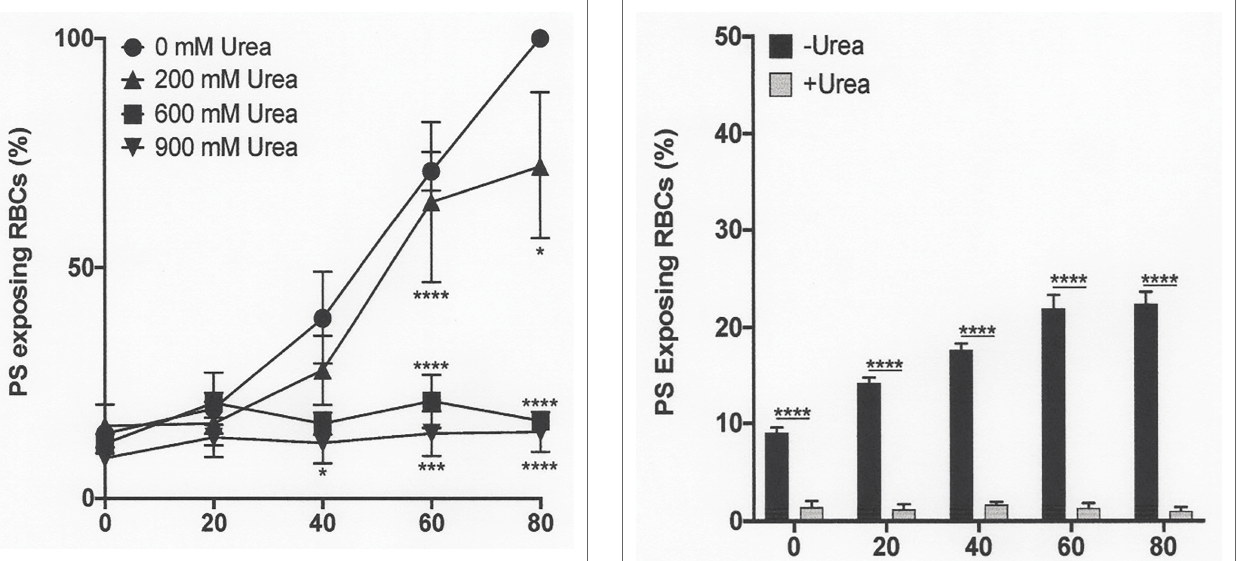
FIGURE 6 | The effect urea on phosphatidylserine exposure in deoxygenated red cells from patients with SCA. Red cells (1% Hct) were incubated in Eschweiler tonometers at 37 o C, pH 7.4 and an osmolality of 290 mOsm.kg-1 for up to 80 min under fully deoxygenated (0 mmHg oxygen) conditions in the absence of urea (0 mM urea) or at three different urea concentrations (200, 600, and 900 mM). At the time intervals indicated, red cell aliquots were removed and PS exposure measured using LA-FITC, as described in the Methods. Symbols represent means ± SEM, n = 3. * p < 0.05; *** p < 0.001; and **** p < 0.0001, comparing red cells in the absence of urea with those in its presence.